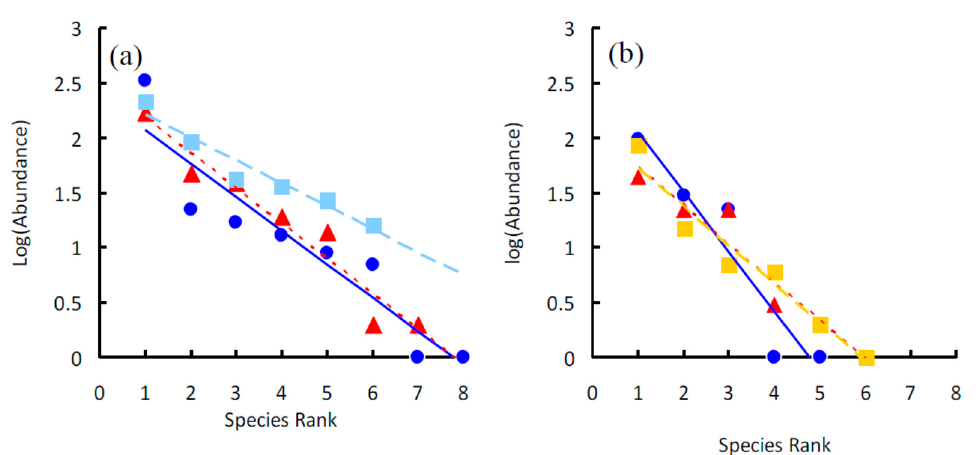
Figure 5. Rank–abundance plots of the tenebrionid beetles collected beneath four plant species in two sites in the Ulan Buh Desert (Gobi Desert, Inner Mongolia, China): Artemisia sphaerocephala (blue dots, continuous line), Nitraria tangutorum (red triangles, dotted line), Phragmites australis (light blue squares, broken line) and Psammochloa villosa (yellow squares, broken line). Species are ranked from the most to the least abundant ( x -axis). Species abundances are log-transformed ( y -axis). The data were fitted using linear regressions. ( a ) Rank–abundance plots for the ensembles of Site A. ( b ) Rank–abundance plots for the ensembles of Site B.